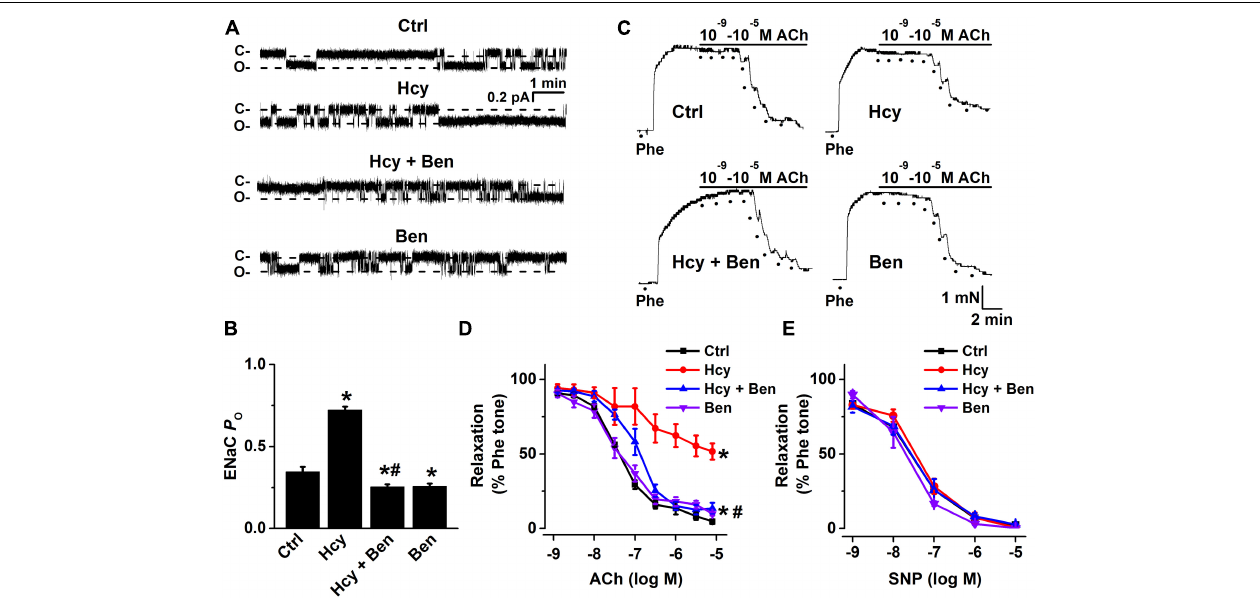
FIGURE 2 | Benzamil attenuates exogenous Hcy-induced increase in endothelial ENaC activity and impairment of EDR in mouse aorta. (A) Representative ENaC single-channel currents were recorded from endothelial cells from split-open aorta either under control conditions or, respectively, treated with 100 µ M Hcy, 100 µ M Hcy plus 0.5 µ M benzamil (Ben), or 0.5 µ M benzamil alone for 6 h. (B) ENaC activity ( P O ) summarized from the recordings as shown as shown in (A) . Data are means ± SEM of six mice. * P < 0.05 vs. ctrl; # P < 0.05 vs. Hcy. (C) Representative traces obtained from wire myograph assays under each indicated condition